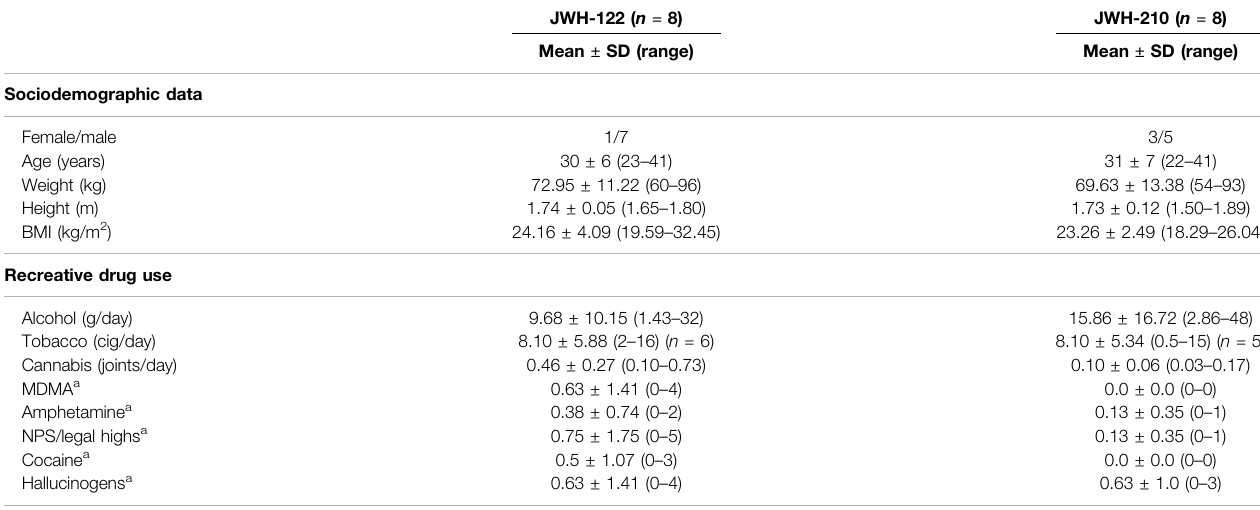
TABLE 1 | Summary of sociodemographic data and recreative drug use for the